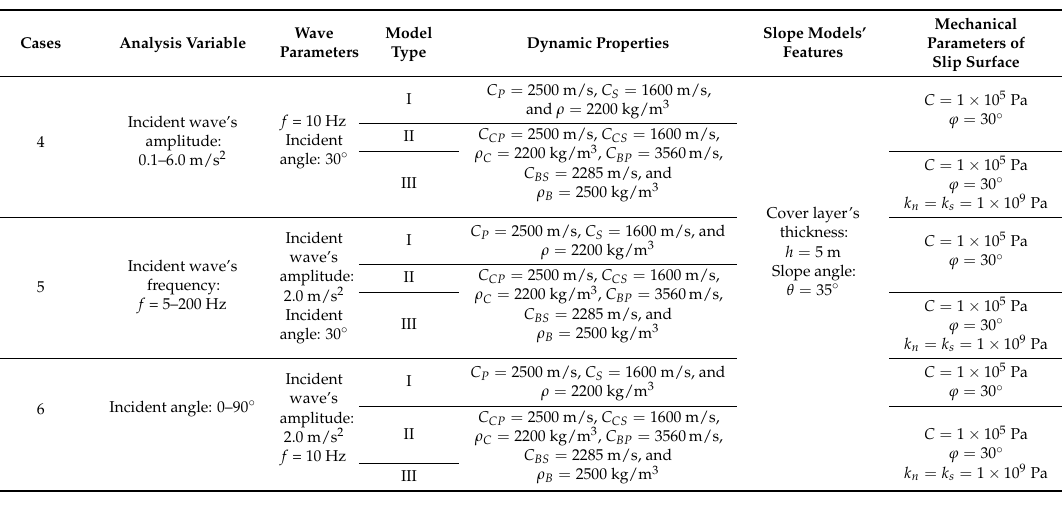
Table 3. The variables and parameters for stress wave’s effect analysis (P- and